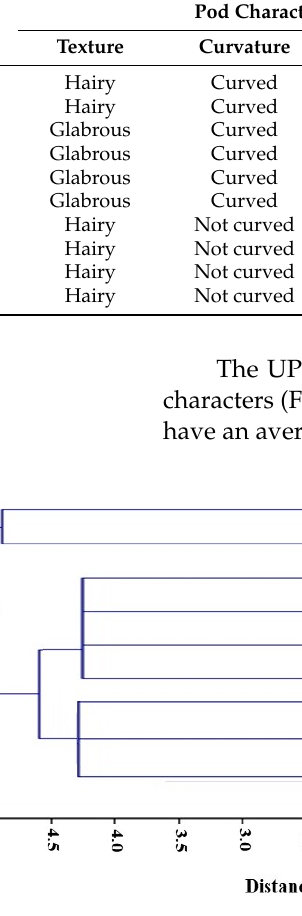
Figure 1. UPGMA dendrogram matrix illustrating the relationships and average taxonomic distance between Astragalus species based on 35 morphological characters.